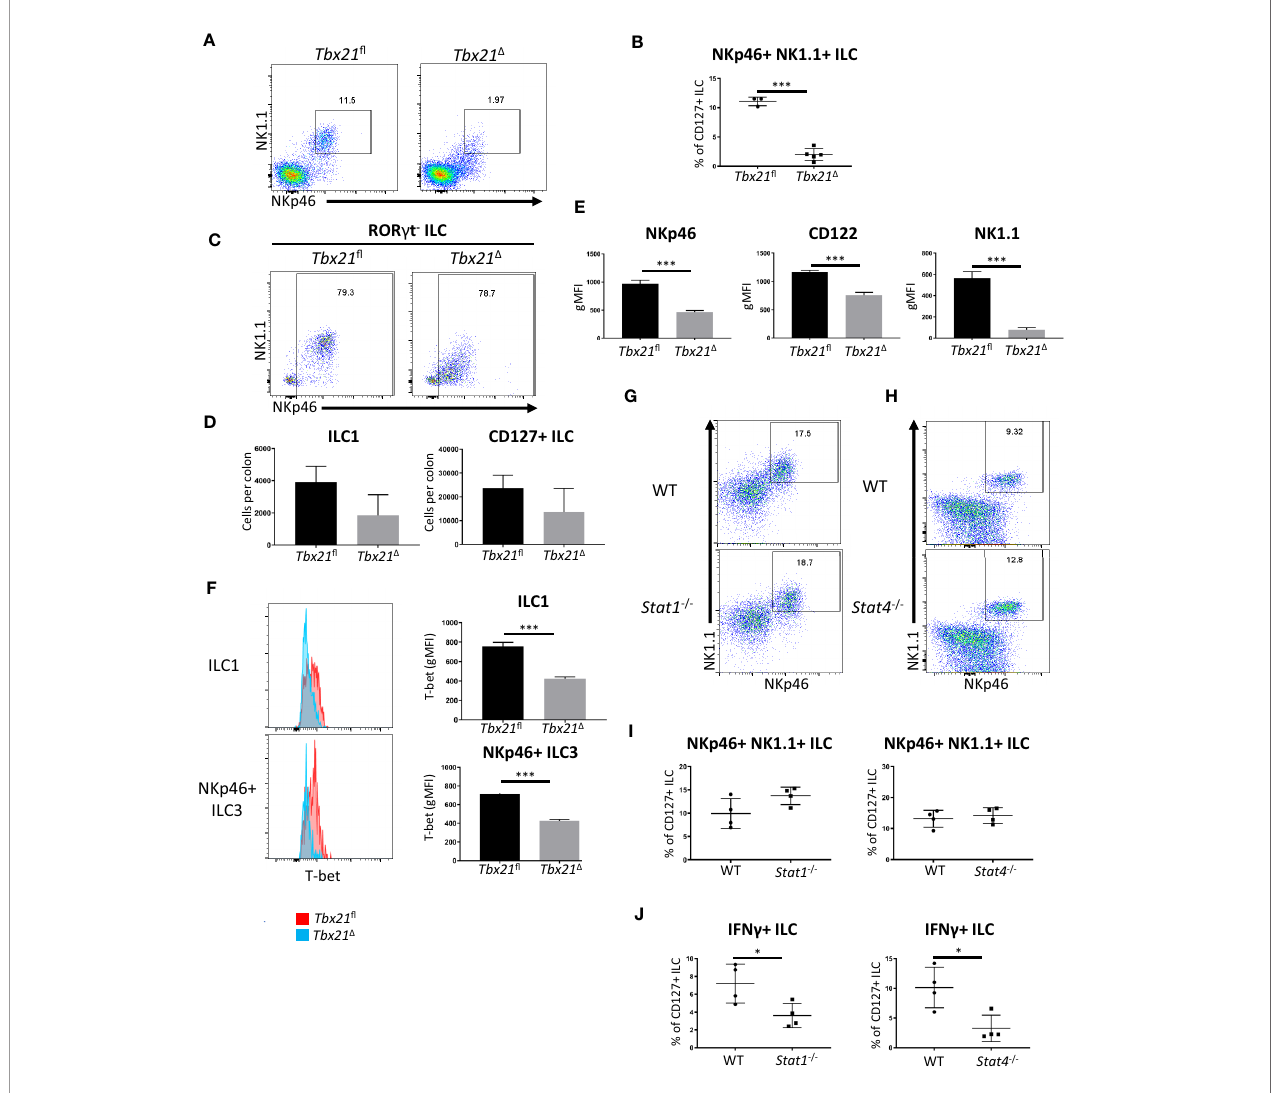
FIGURE 3 | Surface marker expression in ILC1 is altered upon induced deletion of T-bet. cLP leukocytes were isolated from tamoxifen-treated Tbx21 fl and Tbx21 D mice for fl ow cytometry analysis 14 days after the fi rst injection of tamoxifen. (A) Flow cytometry analysis of NKp46 + NK1.1 + cLP ILC and (B) respective frequency statistical analysis among CD127 + ILC are outlined. (C) cLP ILC1 were analysed as CD127 + KLRG1 - ROR g t - NKp46 + NK1.1 +/- ILC (ILC1) and (D) the cell counts per colon in Tbx12 fl and Tbx21 D mice were determined for ILC1 and CD127 + ILC (n=3). (E) gMFI of NKp46, CD122 and NK1.1 surface expression in Tbx21 fl and Tbx21 D ILC1 de fi ned as CD127 + KLRG1 - ROR g t - NKp46 + NK1.1 + ILC was evaluated statistically (n=3). (F) Flow cytometry and statistical analyses of T-bet protein expression in Tbx21 fl and Tbx21 D cLP ILC1 and NKp46 + ILC3 de fi ned as CD127 + ROR g t + NKp46 + ILC are presented (n=3). cLP NKp46 + NK1.1 + CD127 + ILC were analysed in WT, (G) Stat1 -/- or (H) Stat4 -/- mice and (I) the percentage of these cells within the CD127 + ILC population was analysed (n=4). (J) IFN g percentual expression in cLP CD127 + ILC from Stat1 -/- and Stat4 -/- mice upon a 4 hour stimulation with PMA and ionomycin is shown (n=4). ***p < 0.001, *p <